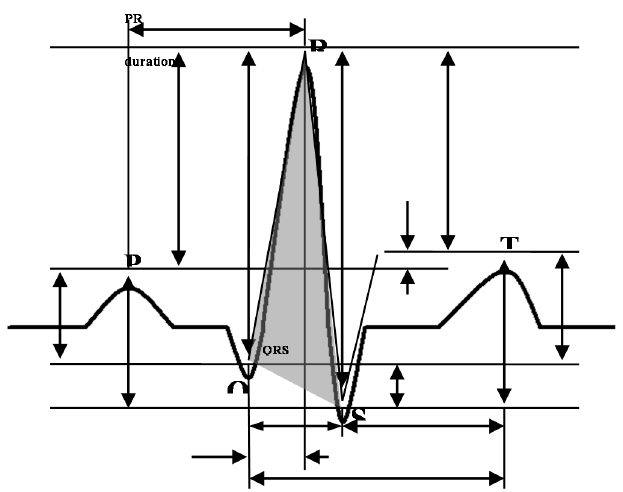
Figure 11. Waveform feature extraction for identification.